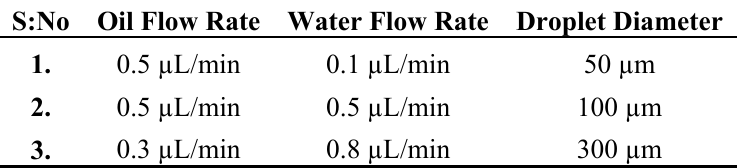
Table 1. Different diameter droplets generation with different flow rates of water and